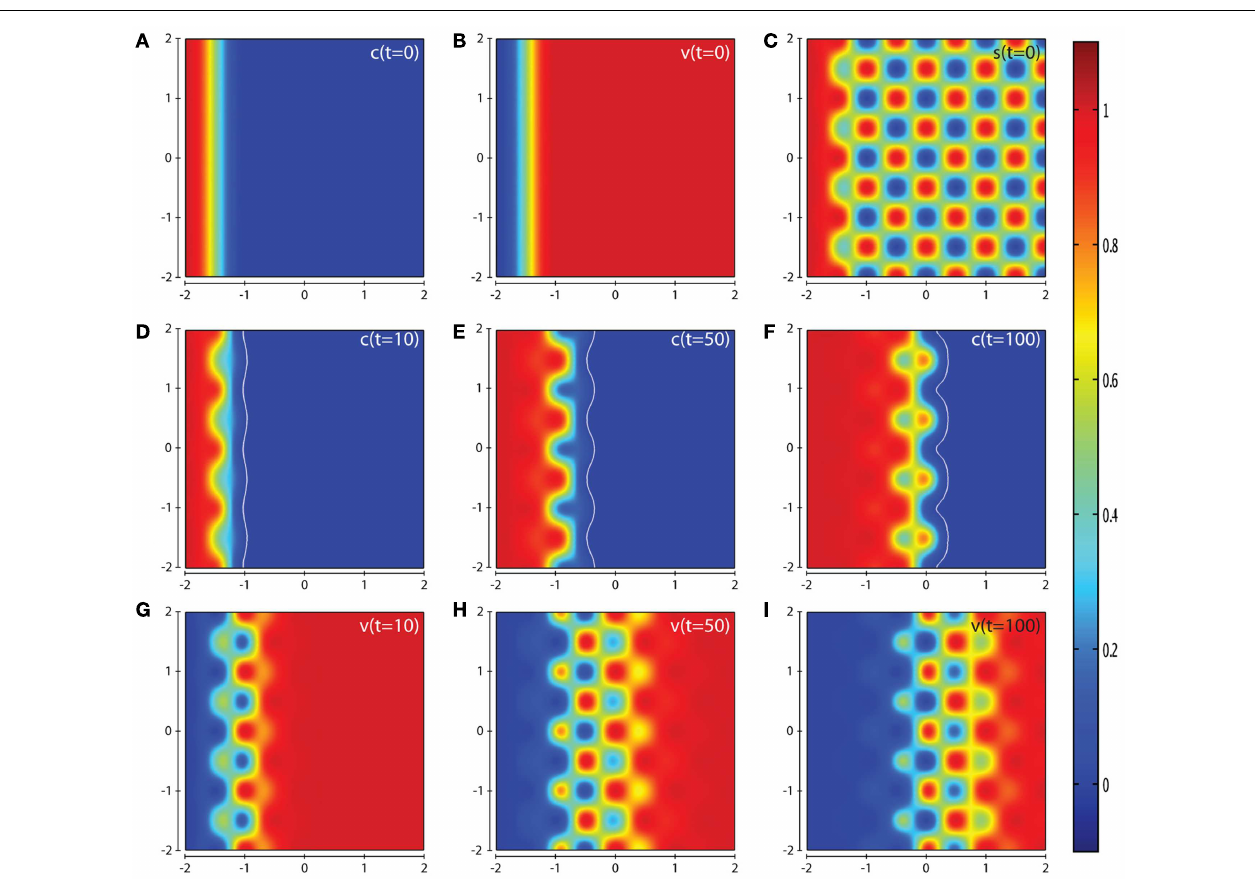
line shows the cancer cell density at level 0.01 chosen to represent the maximum extent of invasion. Plots (G–I) show the resultant profiles of ECM density at t = 10, 50, and 100.The simulations were performed using the baseline parameter set with the exception of the parameter δ s = 0 . 0025.The plots show a highly heterogeneous invasion pattern at the invasive front, once again highlighting the role of the matrix suitability modifier s and the parameter δ s